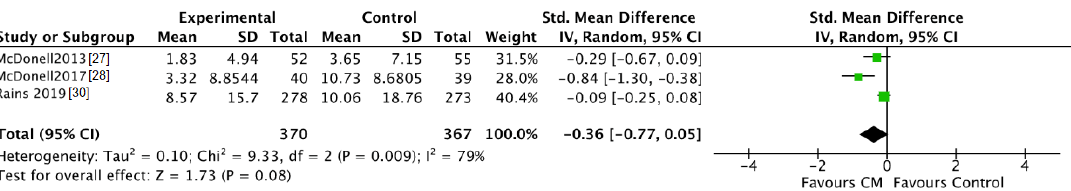
Figure 3. Forest plot of the comparison CM versus standard care after follow-up, number of days using.